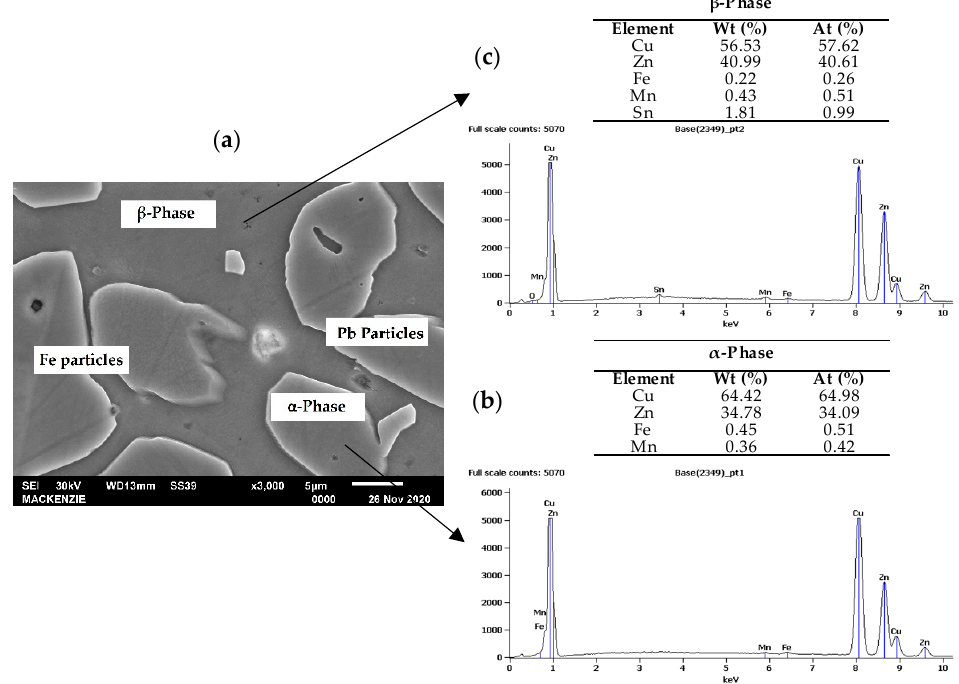
Figure 6. ( a ) SEM micrograph showing the phase structure at higher magnification, EDS spectrum of the ( b ) α -phase area and ( c ) β -phase